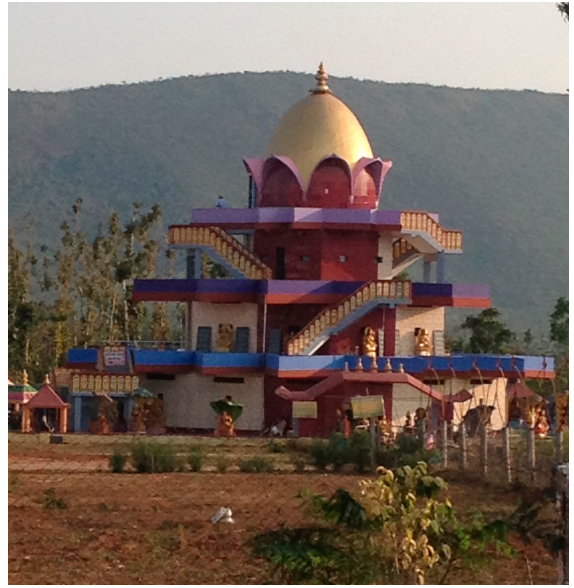
Figure 2. Sahasrakshi Meru temple, Devipuram. Photo by Mani Rao.